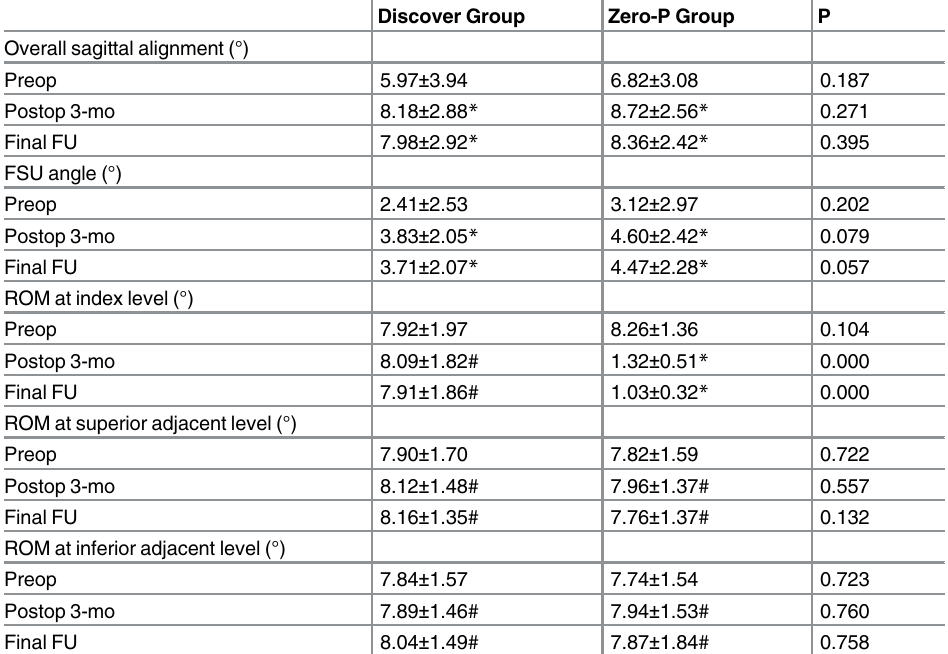
Table 3. Comparison of radiographic outcomes between the 2